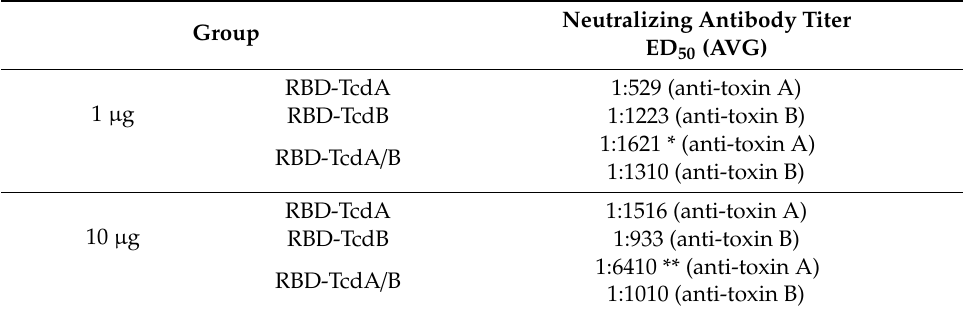
Table 1. Vaccine candidates induced high titers of neutralizing antibody. Table. Vaccine candidates induced high titers of neutralizing antibody. Group